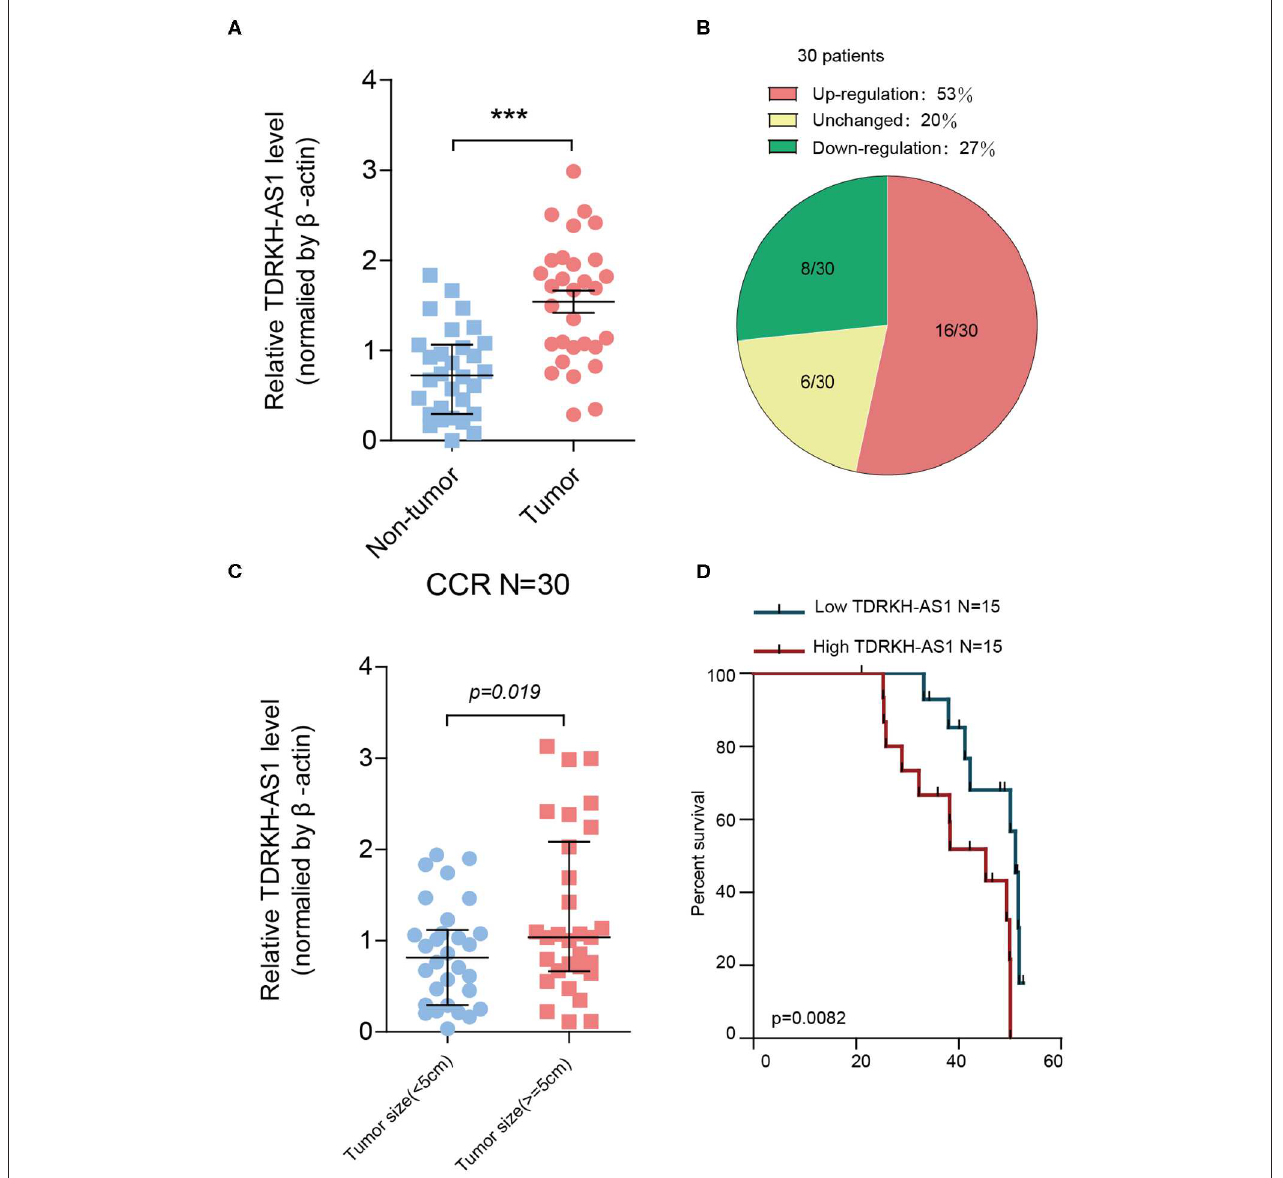
FIGURE 2 | TDRKH-AS1 is upregulated in colorectal cancer (CRC) and negatively correlated with the clinical outcomes of patients of CRC. (A) The relative TDRKH-AS1 RNA levels were quantified in 30 pairs of CRC tissues and adjacent normal tissues by quantitative real-time PCR (qRT-PCR). (B) The pie chart indicates that the ratio of 30 tumor sample TDRKH-AS1 levels in the upregulation (red), unchanged (yellow), and downregulation (green) categories. (C) The upregulation of TDRKH-AS1 is positively correlated with the tumor size ( ≥ 5cm). (D) Using Kaplan–Meier to analyze the relationship between TDRKH-AS1 levels and the percent survival in 30 CRC patients. Statistics were considered to be at a significant level when p < 0.05, where * p < 0.05, ** p < 0.01, and *** p <